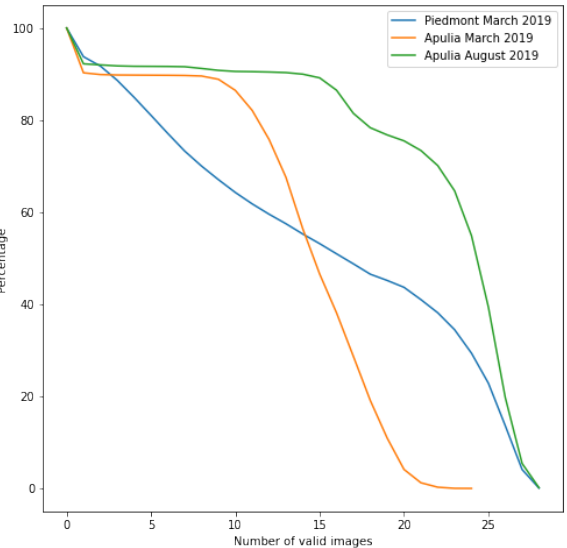
Figure 7. Percentage of valid pixels in the image for a given number of